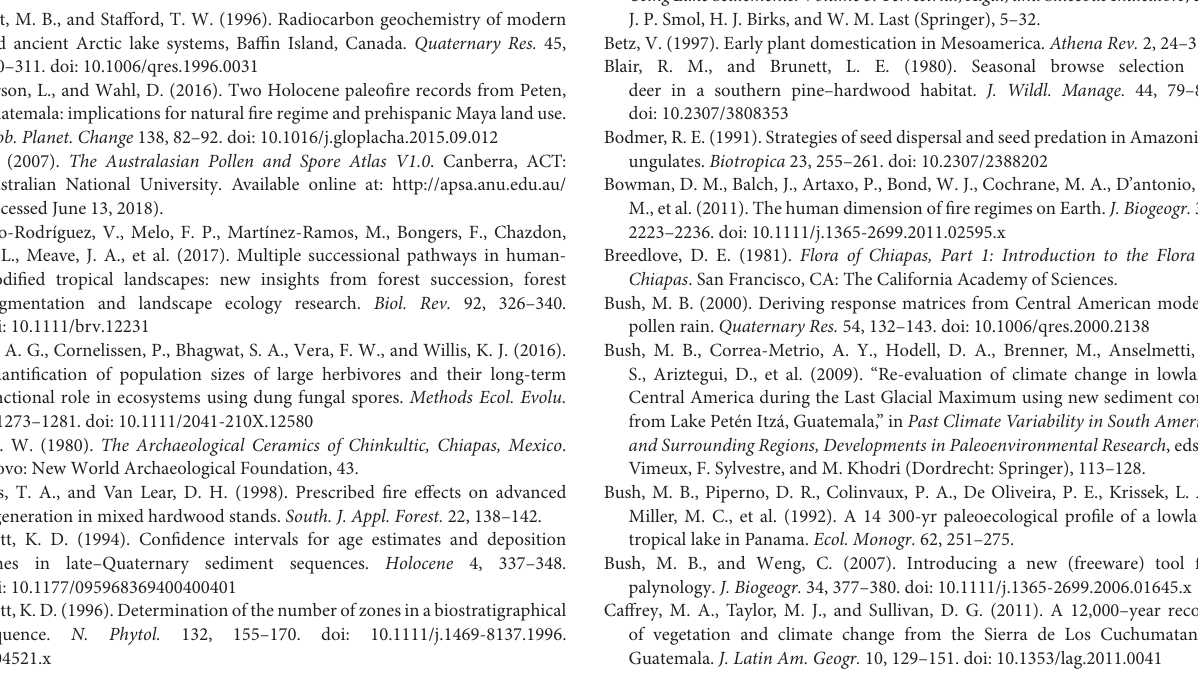
Supplementary Table 1 | Sites represented on Figures 1 and 2 .